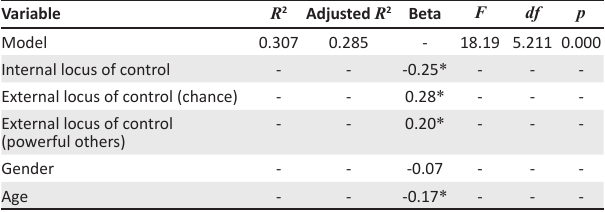
TABLE 3: Locus of control, gender and age as predictors of depression. Variable